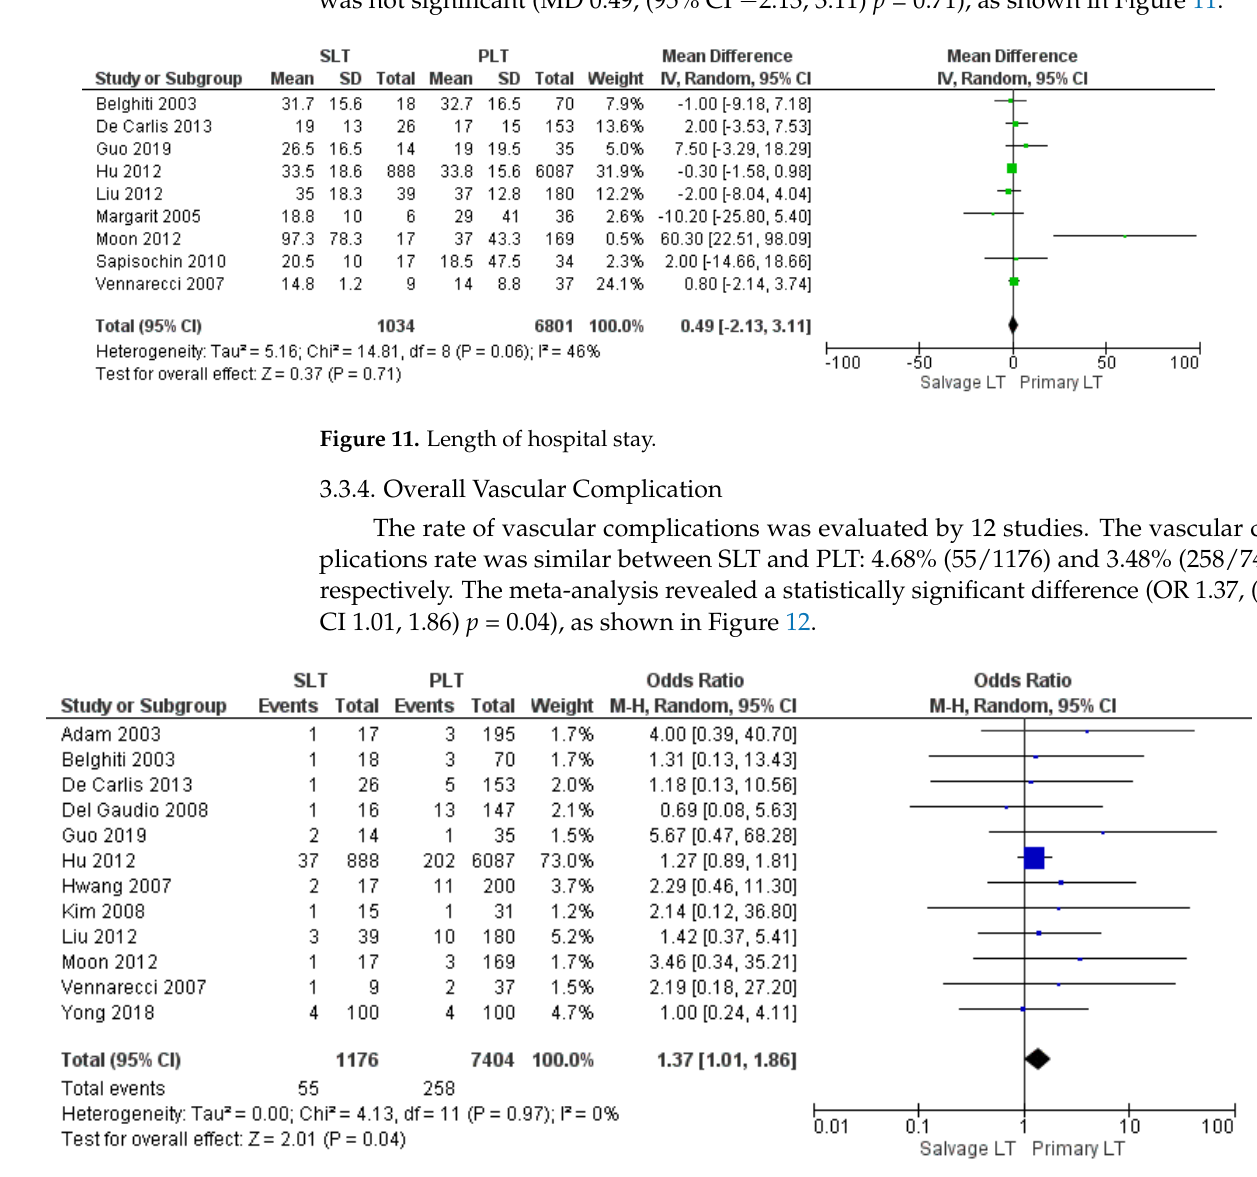
Figure 13. Arterial thrombosis. 3.3.6. Biliary Complications Thirteen papers analyzed the frequency of biliary complications (stenosis, leakage, and fistula). The biliary complication rate was significantly higher in the SLT group than the PLT group: 13.6% (162/1191) and 11.2% (838/7449), (OR 1.22, (95% CI 1.01, 1.47) p = 0.04), as shown in Figure 14.